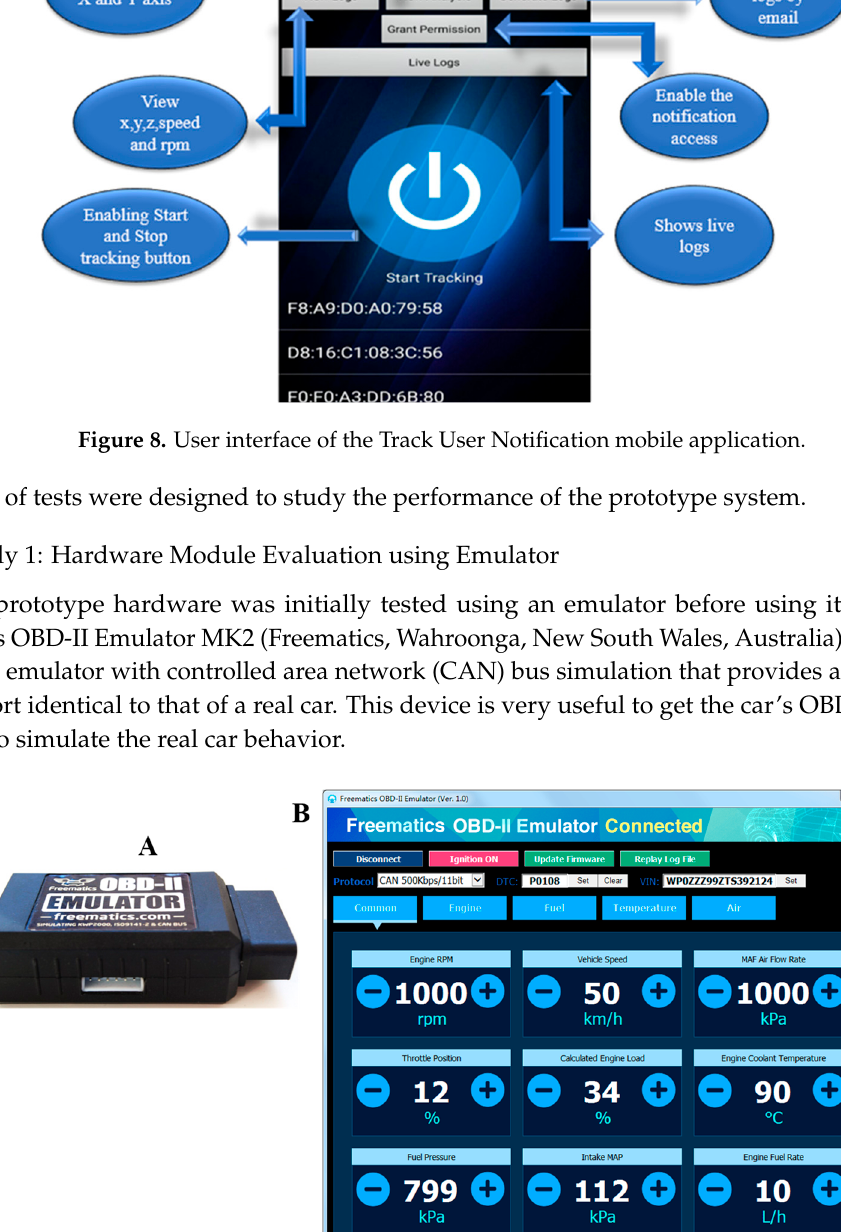
Figure 7 . Screen shots of some of the mobile application’s features.